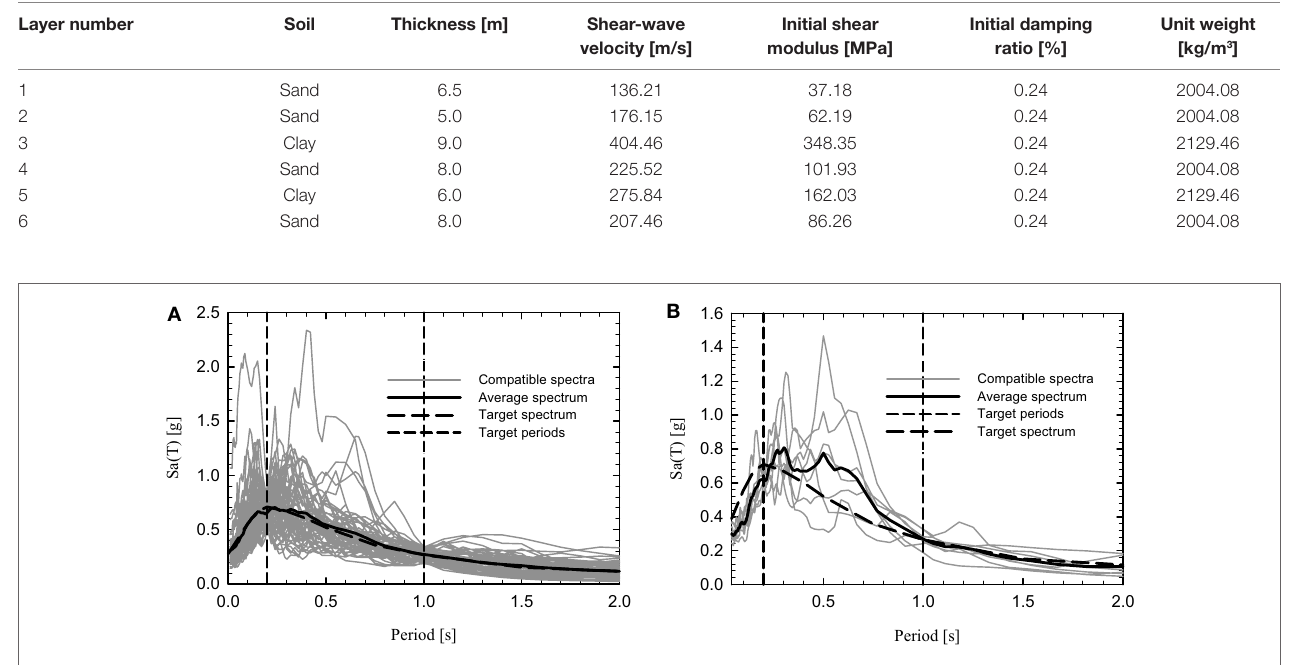
TaBle 6 | geotechnical soil characteristics.